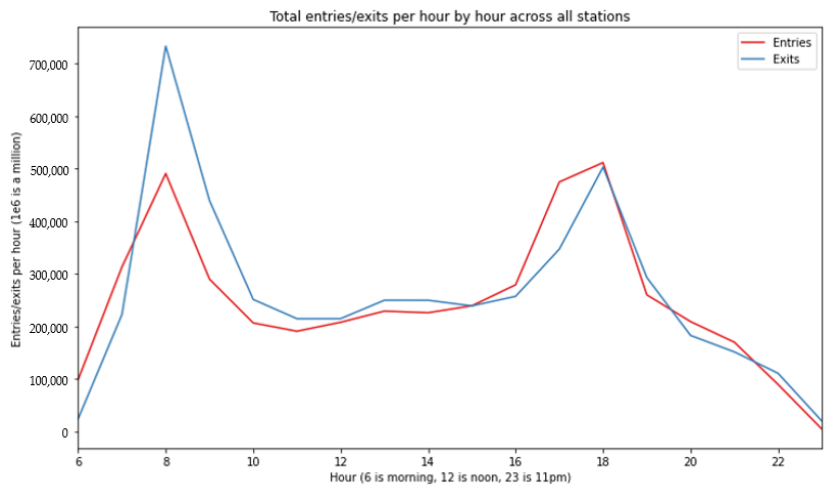
Figure 10. Hourly average inbound/outbound passenger flow statistics.